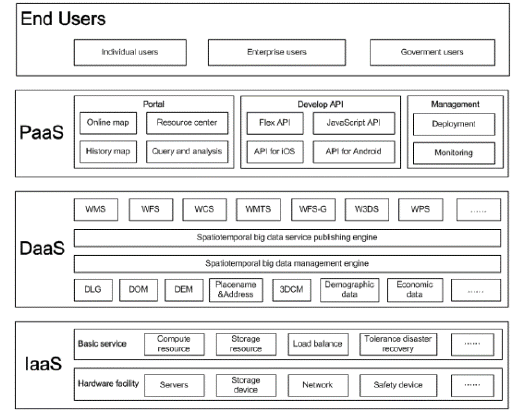
Figure 2. Framework of spatio-temporal big